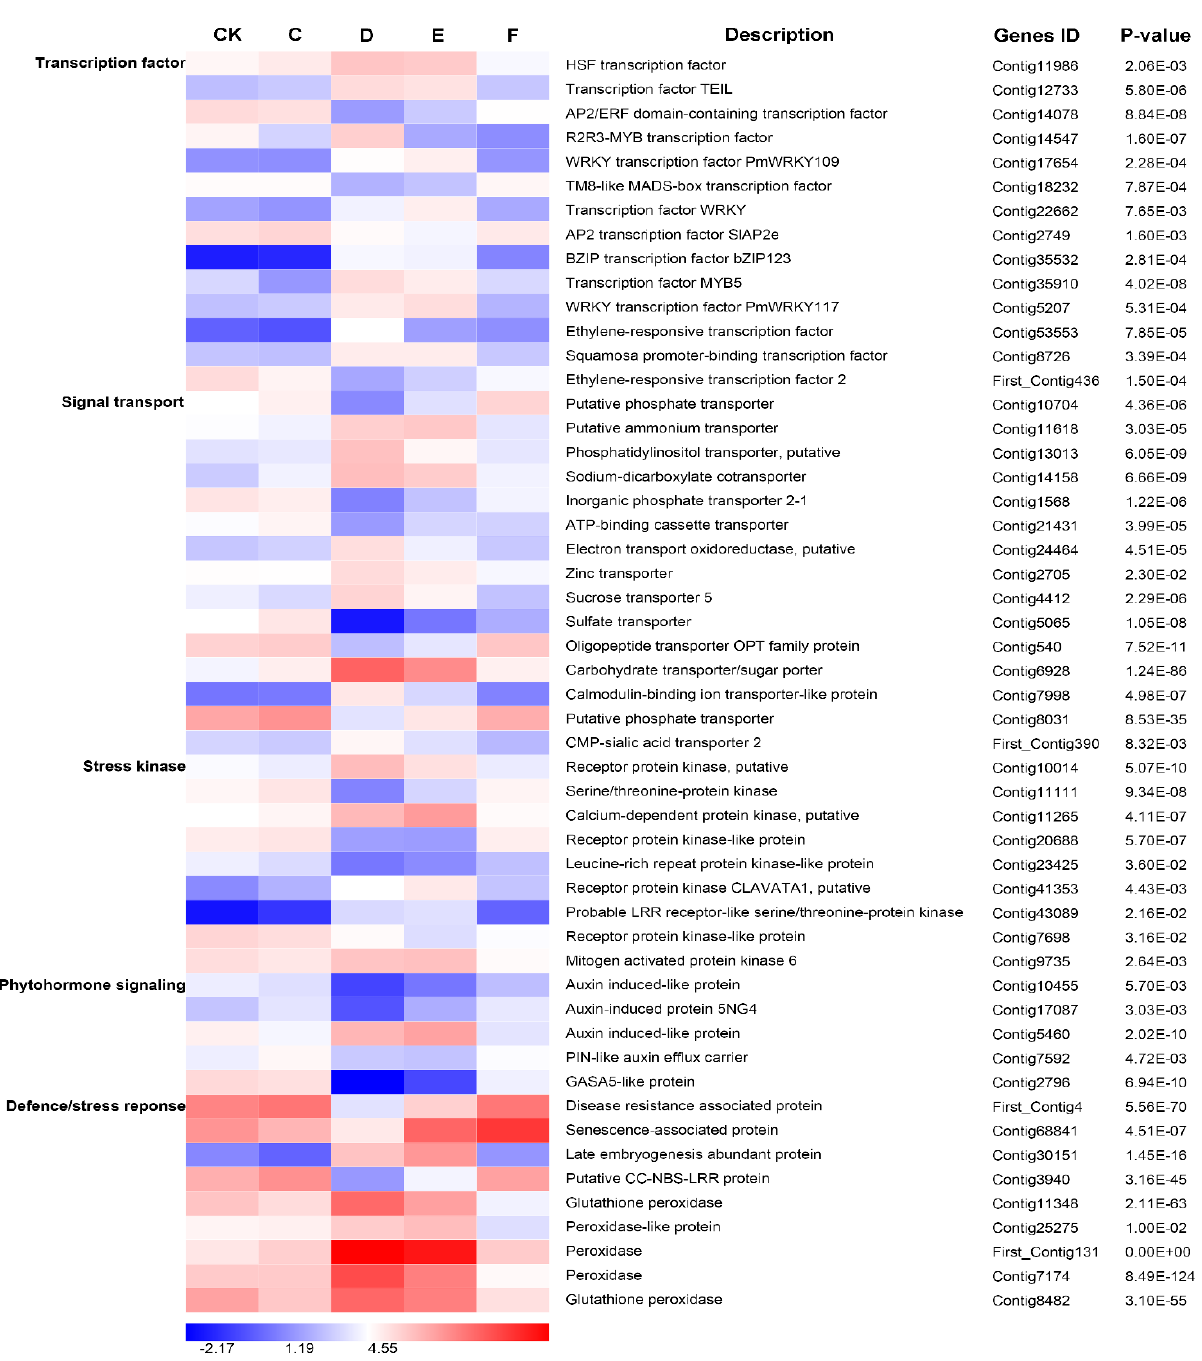
Figure 5. Heat-map of 52 differentially expressed genes. These genes were involved in transcription factor, signal transport, stress kinase, phytohormone signalling, and the defence/stress response, in the drought response and acclimation of Chinese fir. These genes were differentially expressed among the control 0 h (CK), drought treatments 5 day (C), 10 day (D) and 15 day (E), and re-watering (F). The bar represents the expression level of each gene (log2RPKM [number of reads per kilobase per million clean reads]) in the drought response and acclimation as indicated by blue/white/red rectangles. Low to high expression is indicated by a change in colour from blue to white to red. Complete information for each gene list can be found in Table